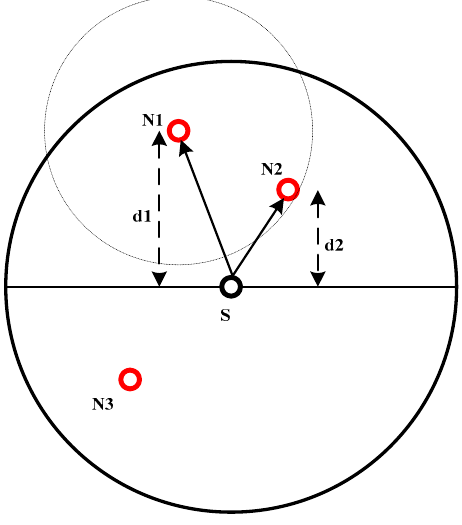
Figure 10. Packet forwarding process in DBR.